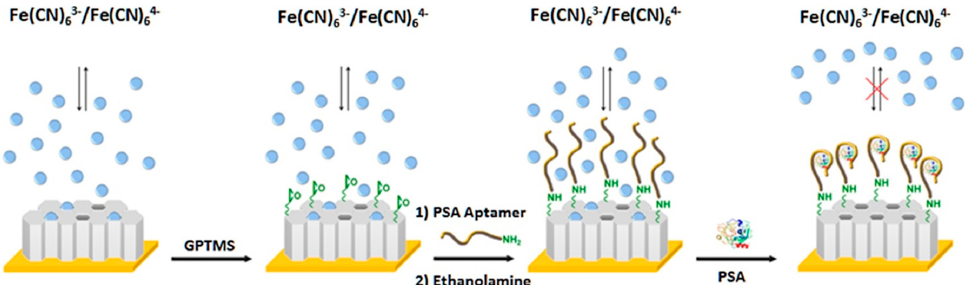
Figure 19. Label-free electrochemical aptasensor for PSA detection developed at an MSF-AuE. Reprinted and adapted from [176] with permission.